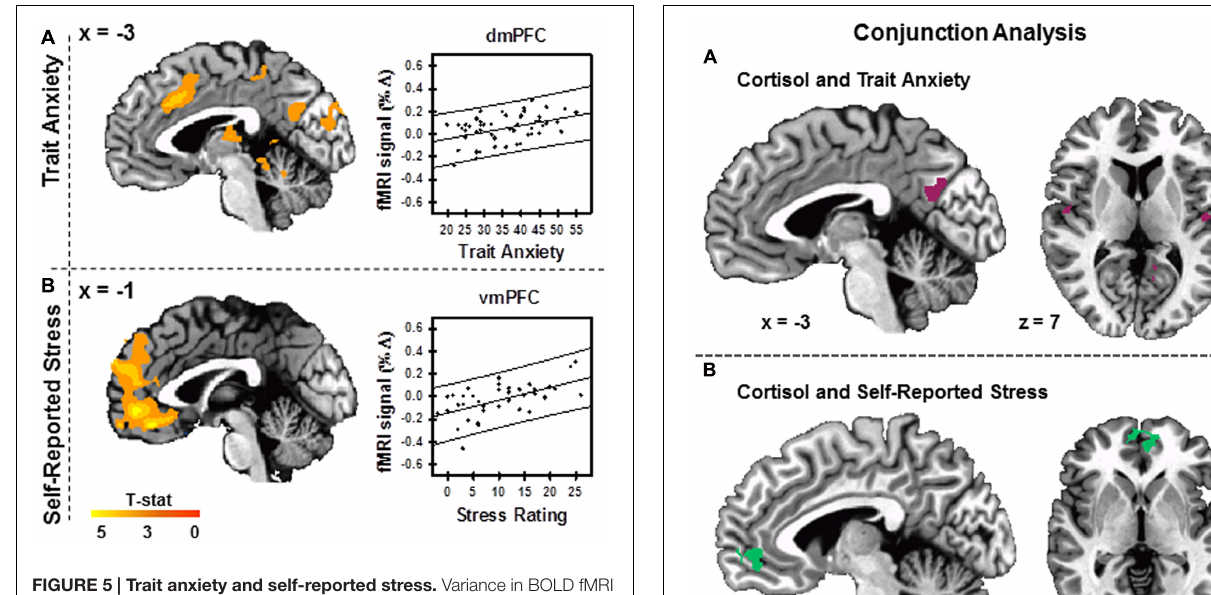
FIGURE 5 | Trait anxiety and self-reported stress. Variance in BOLD fMRI signal during Stress vs. Control conditions varied with trait anxiety score (A) ( N = 53) and self-reported stress (B) ( n = 40). Scatterplots display peak activation within the dmPFC ( x = − 3, y = 19, z = 35) (A) and vmPFC ( x = − 1, y = − 45, z = − 16) (B) . Images are FWE corrected at p < 0.05 and presented in radiologic view. FIGURE 6 | Conjunction of psychobiological measures associated with